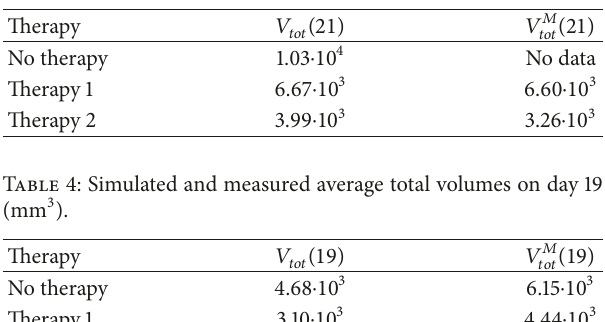
Table 3: Simulated and measured average total volumes on day 21 (mm 3 ).